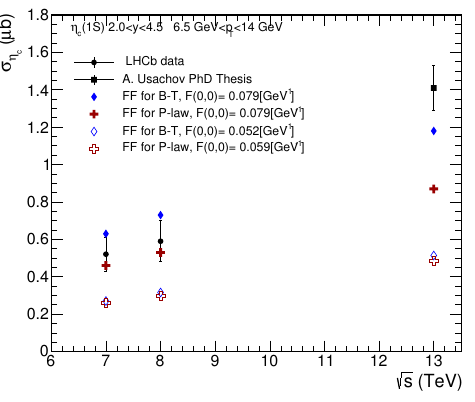
Figure 12 . The integrated cross section computed within LHCb range of p T and y with our transition form factors, compared to experimental values. Here red crosses represent values for Buchm(cid:127)uller-Tye potential (B-T) and deltoids for Power-law potential